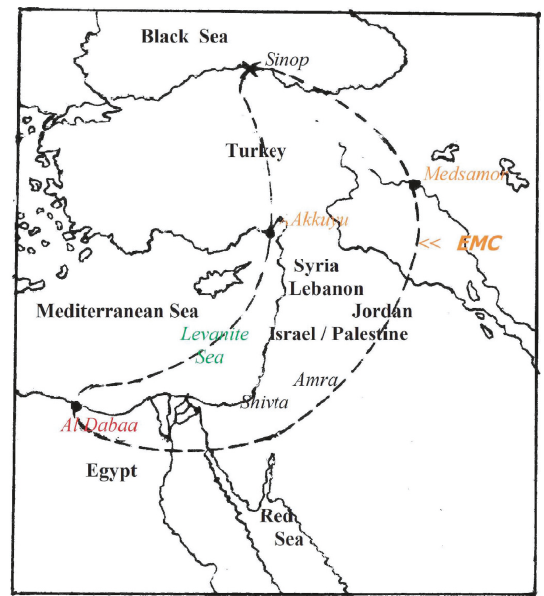
Figure 1: Geography of the East mediterranean crescet Table 1: List of NPP’s in the EMC.